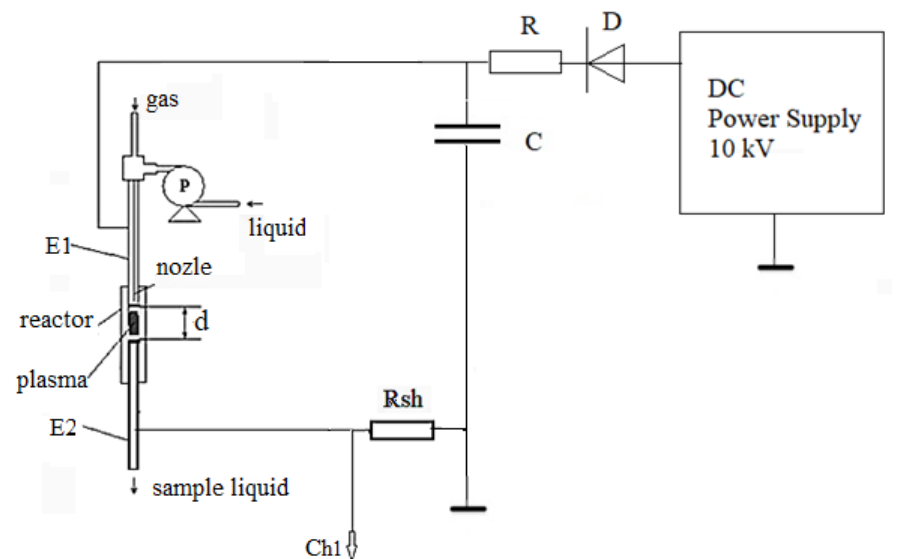
Figure 5. The schematic of the NTP reactor with R–C pulse generator (RCG). After the full discharge of the capacitor, the process starts over from the beginning. The voltage and current waveforms are presented in Figure 6.